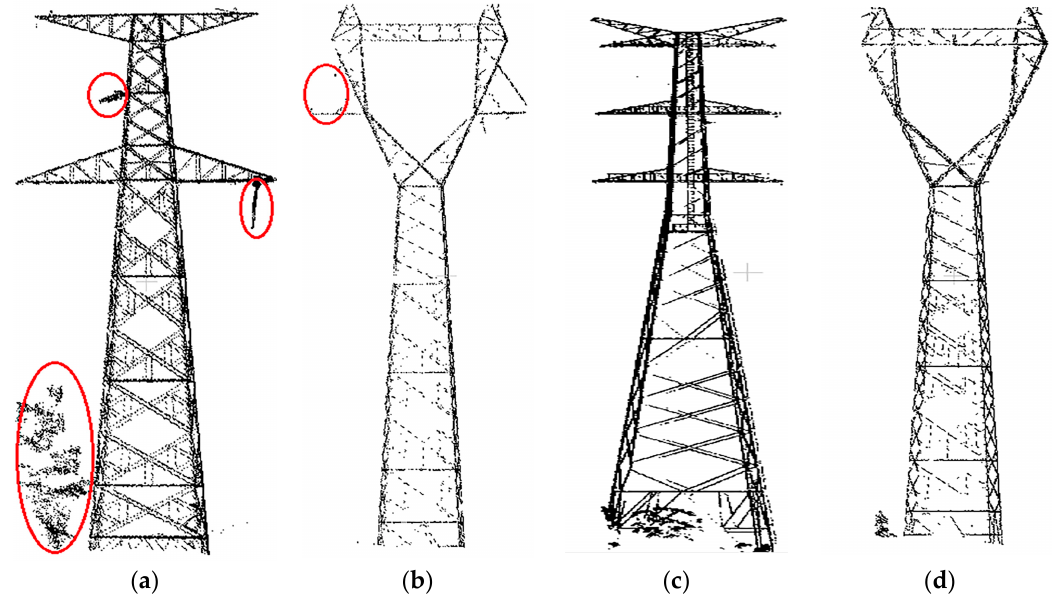
Figure 11. Original point cloud data of four typical pylons. ( a ) pylon of Type 1; ( b ) pylon of Type 2; ( c ) pylon of Type 3; ( d ) pylon of Type 4.